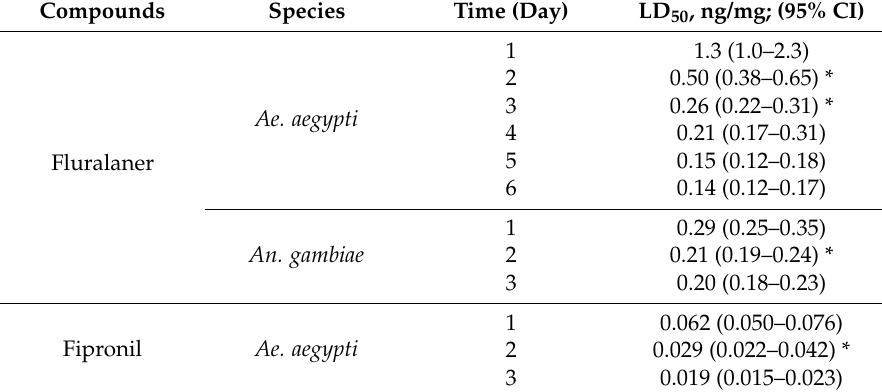
Table 2. Topical bioassays of fluralaner on Ae. aegypti and An. gambiae adult females. Compounds Species